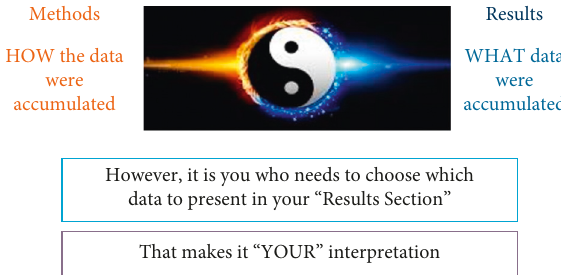
Figure 8: Interdependence between methods and results of the manuscript.